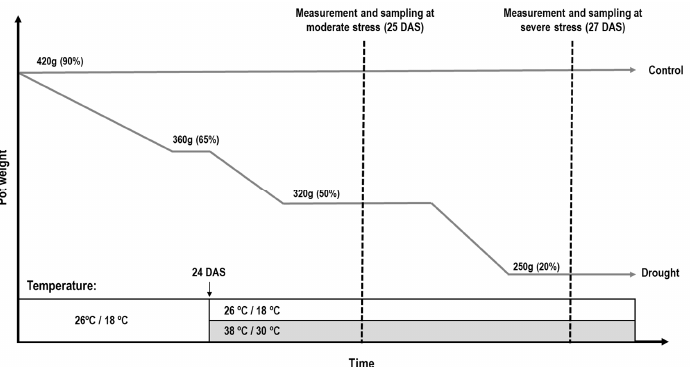
Figure 6. Overview of the workflow for application of drought and heat stress. The 22-day-old tomato plants were divided into either control, individual drought stress, individual heat stress or combined heat and drought stress. Plants of the control treatment were maintained at 420 g (SRWC: 90%) at 26/18 °C throughout the whole experiment. Plants of the individual drought treatment were all ramped down to a set point of 360 g (SRWC: 65%), which was reached at 24 DAS. From here, they were further ramped to a set point of 320 g (SRWC: 50%) for measurements and sampling at moderate drought stress and, hereafter, a set point of 250 g (SRWC: 20%) for measurements at severe drought stress. Plants in the heat treatment were subjected to increased temperature at 38/30 °C from 24 DAS until the end of experiment. The plants of the combined stress treatment received a combination of the drought and heat treatment.